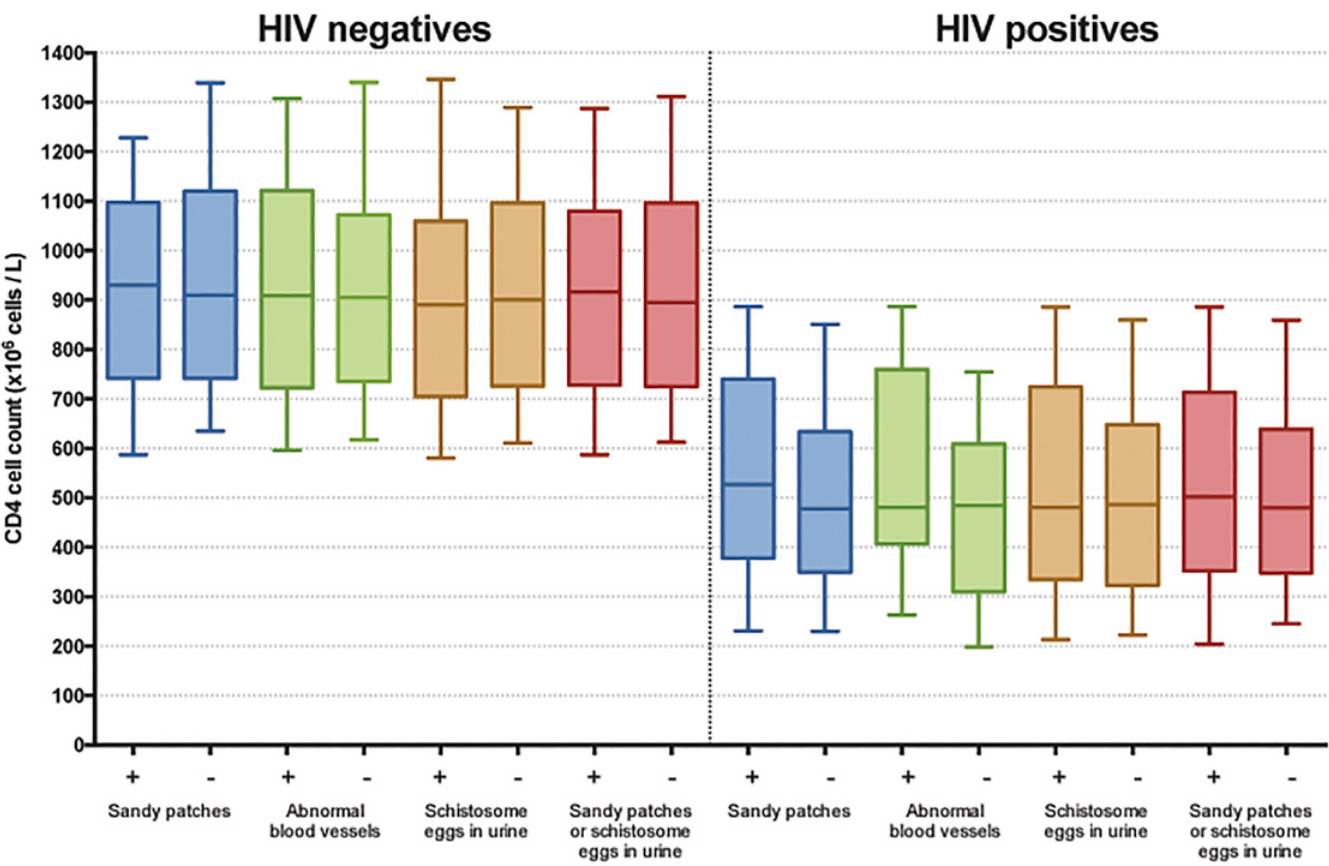
Fig 2. Genital lesions, urinary schistosomiasis and CD4. Boxplots showing CD4 cell counts in HIV negative and positive women with different findings of urogenital schistosomiasis. The whiskers represent the 10th and 90th percentiles. The mean CD4 cell counts showed no significant differences between any of the